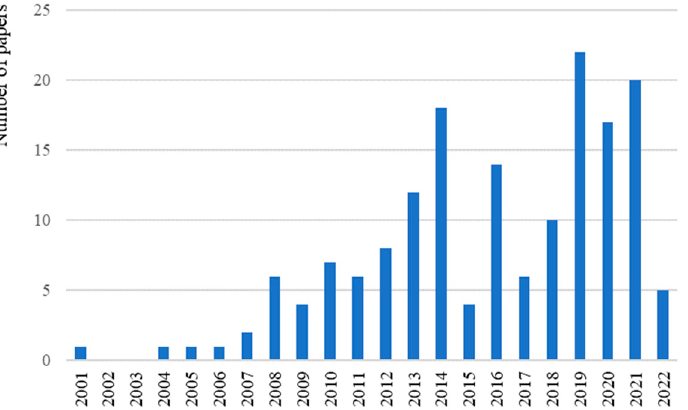
Figure 2. Number of papers related to city logistics and tourism. Source: Own elaboration based on data from the Scopus database.